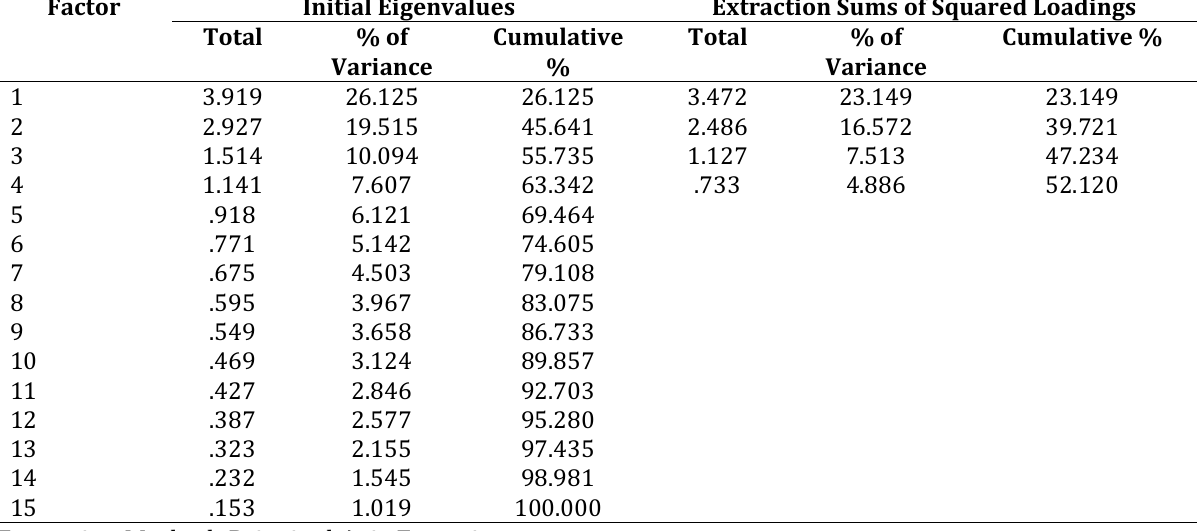
Table 9: Total variance of factors influencing passenger traffic at the domestic airport